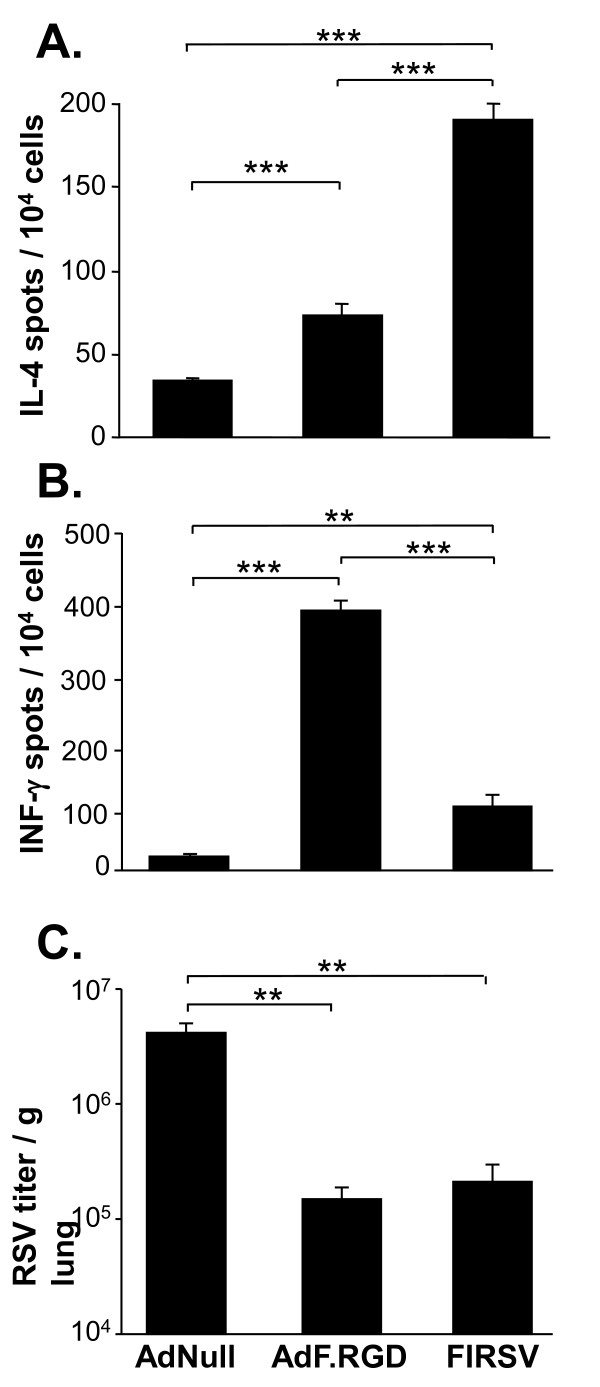
Frequency of RSV-specific Th2-type CD4 and CD8 T cells and protection. BALB/c mice were immunized subcutaneously with AdNull (1010 pu/mouse), AdF.RGD (1010 pu/mouse) or FIRSV (105 pfu) A, B. Ten days following immunization spleen CD4 and CD8 T cells were cultured with splenic DC pulsed with UV-inactivated RSV (105 pu/ml) for 48 h. RSV-specific cytokine response were determined by ELISPOT assay. A. RSV-specific IL-4 production in CD4 T cells. B. RSV-specific IFN-γ production in CD8 T cells. C. RSV titer in the lungs of mice challenged by intranasal administration of RSV (106 cfu) 4 wk after immunization. Data represent mean ± SD of 5 animals/group from one of two independent experiments. *** and ** denote significance of p < 0.001 and p < 0.01, respectively.